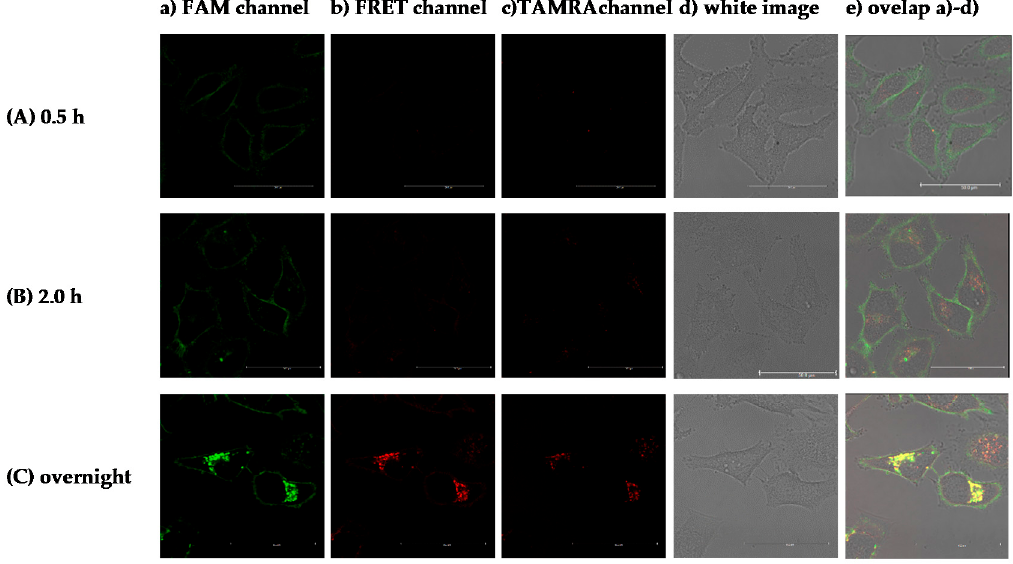
Figure 6. Confocal microscopy analysis of HeLa cells treated with 50 nM Ch(F-TBA-T) for 0.5 h ( A ), 2 h ( B ) and overnight ( C ). Fluorescence emission filters: (1) for FAM channel (green), 510–540 nm, excitation wavelength: 480 nm; (2) for TAMRA channel (red), 595–630 nm, excitation wavelength: 560 nm; and, (3) for FRET channel, 595–630 nm, excitation wavelength: 480 nm. Scale bars: 50 μ m.